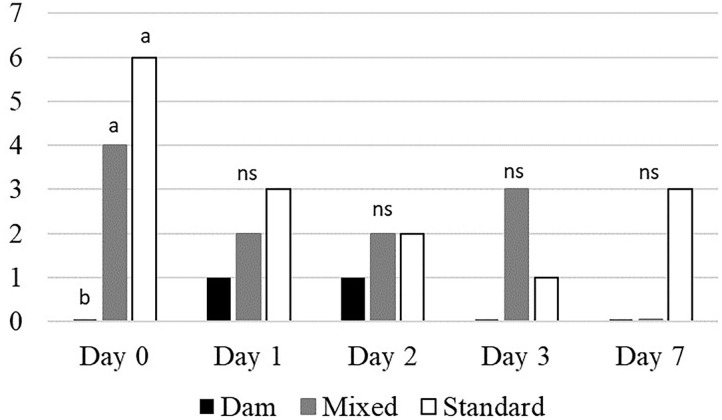
Overall number of calves that tasted Rumex each day (n = 8 calves × 3 groups). a−bMeans with different superscript differ at p < 0.05, Khi2 test; ns, not significant.